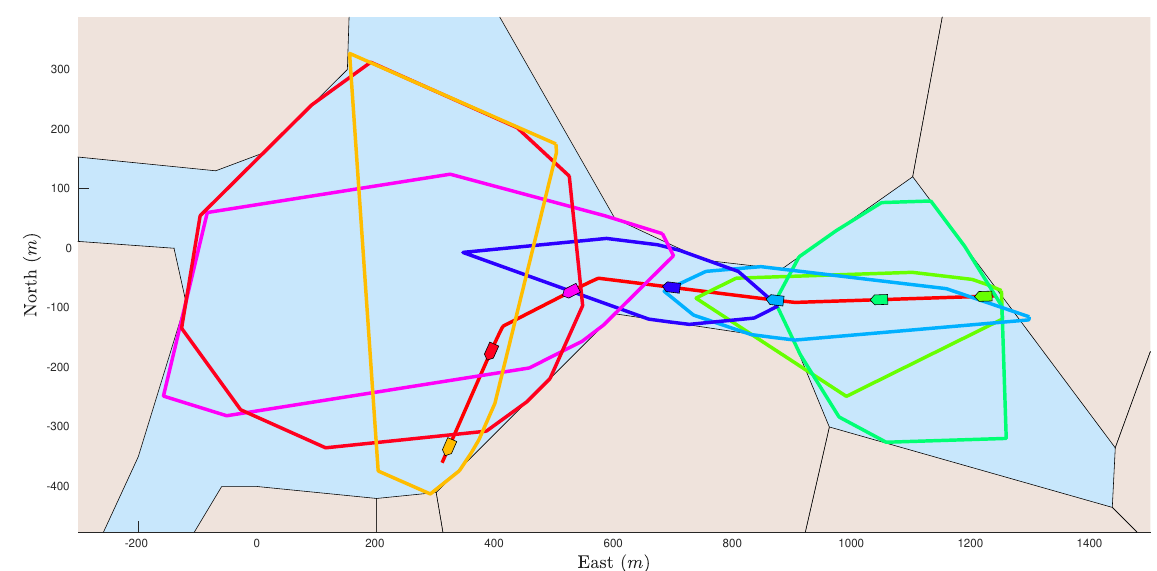
Figure 6: Convex free sets w.r.t. static obstacles with N sect = 12. The figure shows sets for OS at intervals of 70 s along a reference trajectory in red. Color of set boundary correspond to color of vessel. convex free set is more ellipse-shaped for the two blue sets, where the reference position is in a narrow